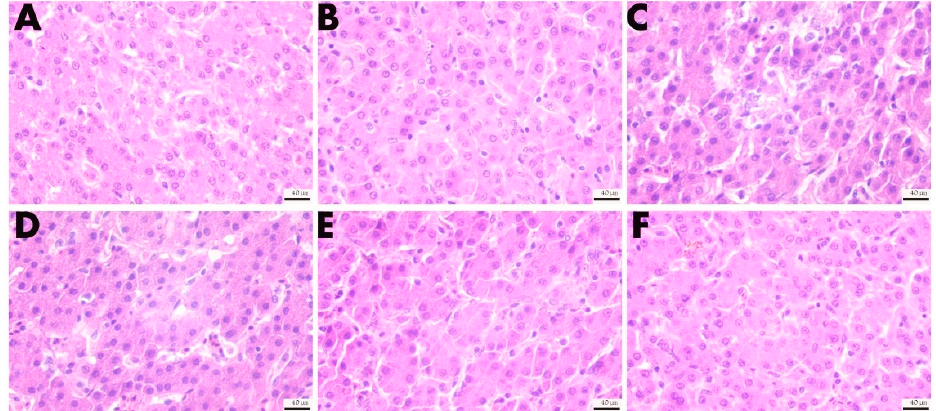
Figure 8. Effects of different levels of VD 3 supplementation on the morphological structure of liver tissue in the Wenchang chicken oxidative stress model (400 × ). ( A ) CK group, ( B ) 4000VD group, ( C ) DI group, ( D ) 1000VD+DI group, ( E ) 2000VD+DI group, ( F ) 4000VD+DI group.